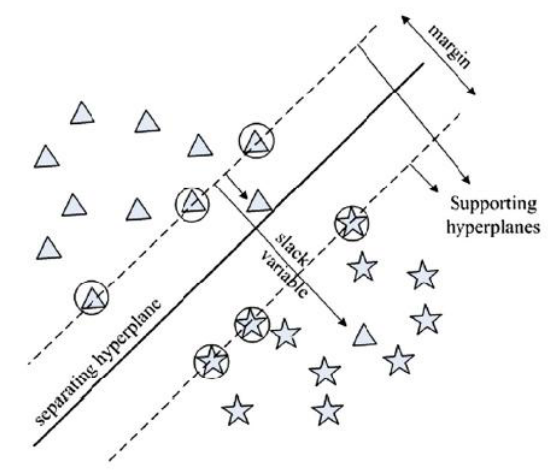
Figure 3: The schematic illustration of SVM.